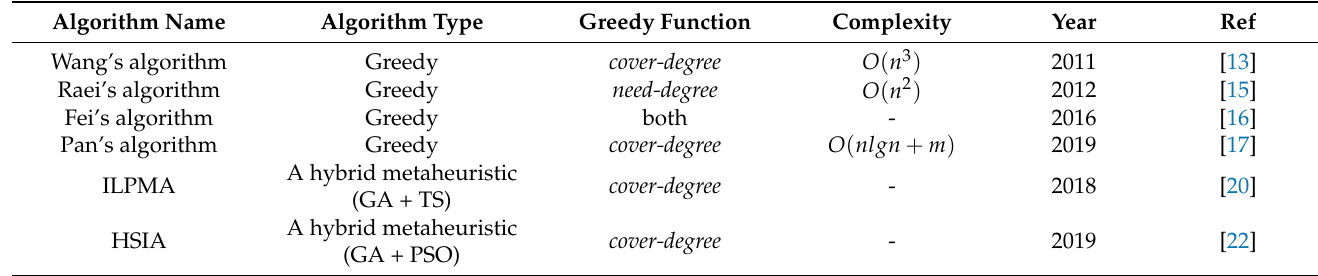
Table 1. Greedy functions used in the existing literature.